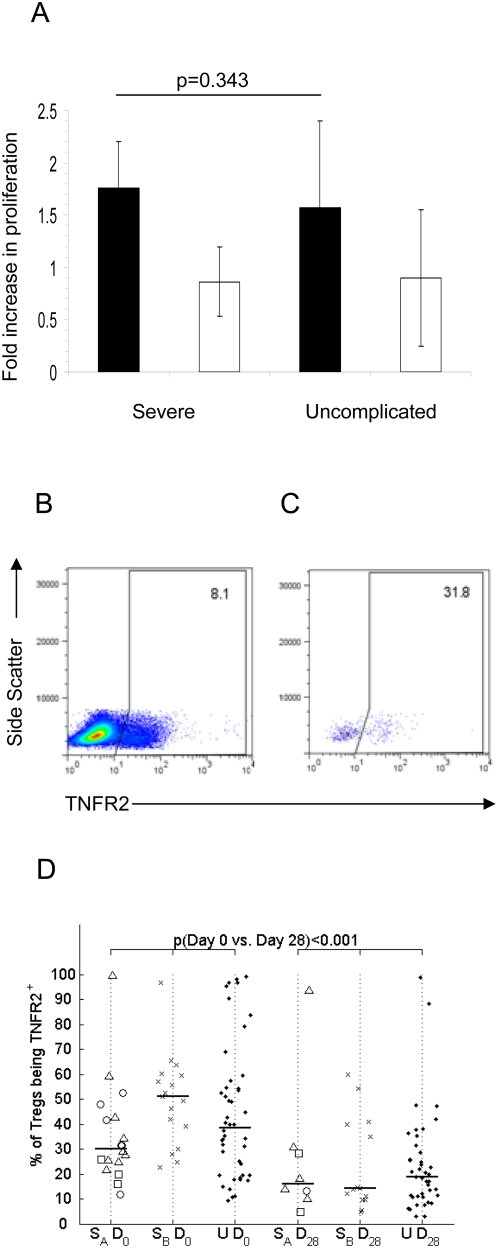
Tregs from severe and uncomplicated cases have similar functional capacity.(A) PBMC from 10 severe and 10 uncomplicated cases collected on day 0 were depleted of CD25+hi cells or mock depleted using magnetically labelled beads (Dynal), and assessed for proliferation using [3H]-thymidine after 6 days in culture with P. falciparum shizont extract (PfSE), uninfected red blood cells (uRBC), PMA+Ionomycin (P+I), or growth medium (GM), respectively. The geometric mean fold increase in proliferation with 95% CI is shown for the stimulation index of  (black bars) or  (white bars). (B) Representative examples of TNFR2 expression on PBMC, and (C) on Tregs. (D) Proportion of Tregs that express TNFR2. Symbols, bars and p-values as defined in Figure 1.